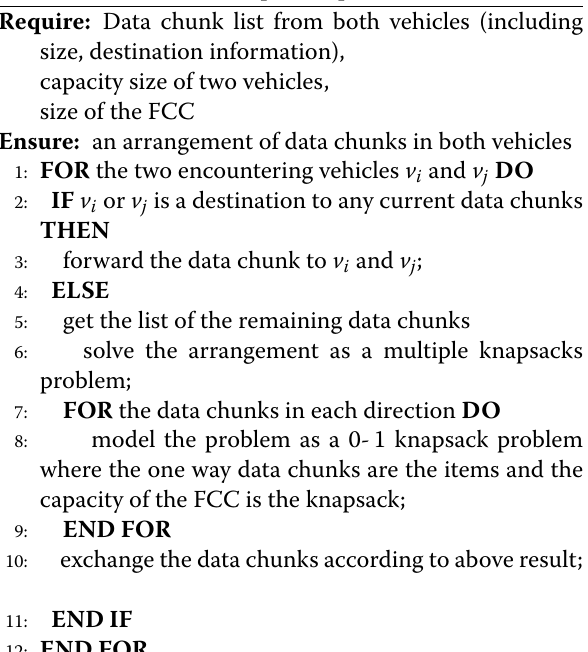
Algorithm 1 Large data chunk forwarding with FCC constraint based on Multiple Knapsack